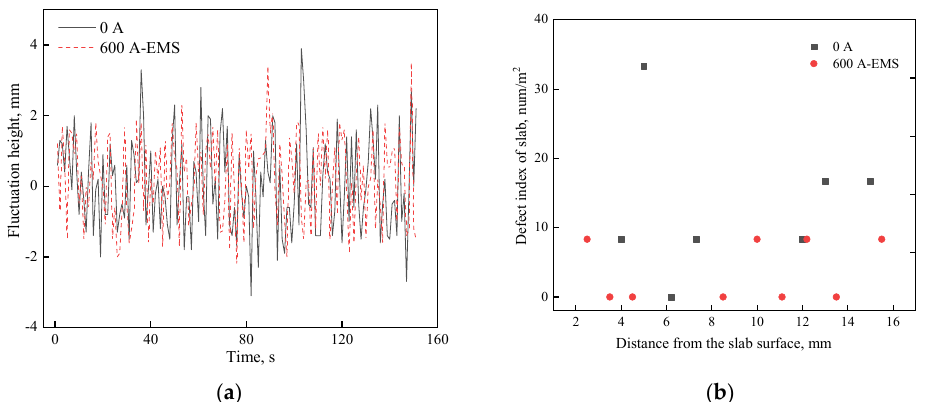
Figure 15. Industrial test: ( a ) transient level fluctuation at quarter of mold, ( b ) number density of inclusion.